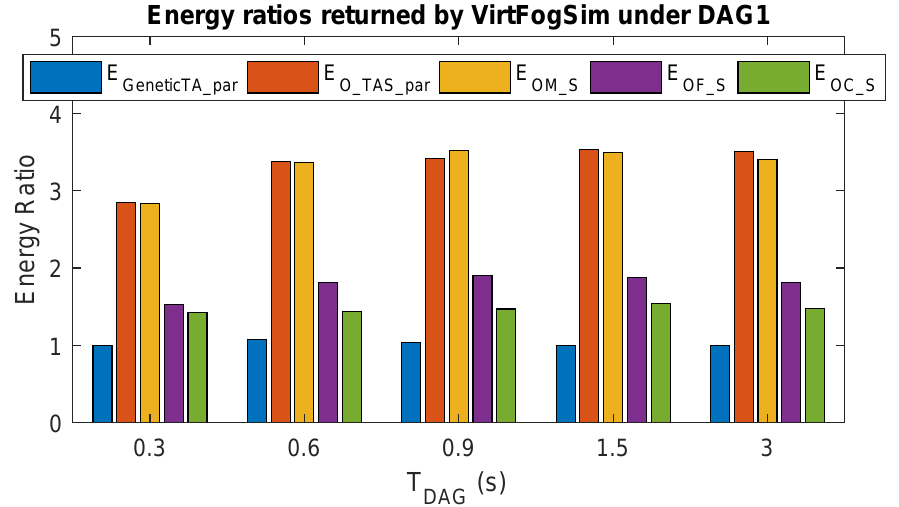
Figure 10. Energy ratios returned by VirtFogSim under DAG1 for T DAG = 0.3 s, 0.6 s, 0.9 s, 1.2 s, and 1.5 s. All the reported ratio values are normalized with respect to the corresponding total energies consumed by ES_S_par